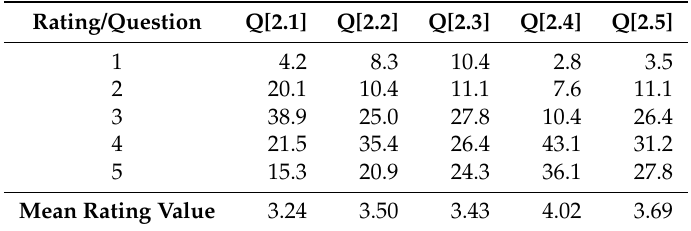
Table 6. Post-test results (second survey)—percentage (%) of answers per